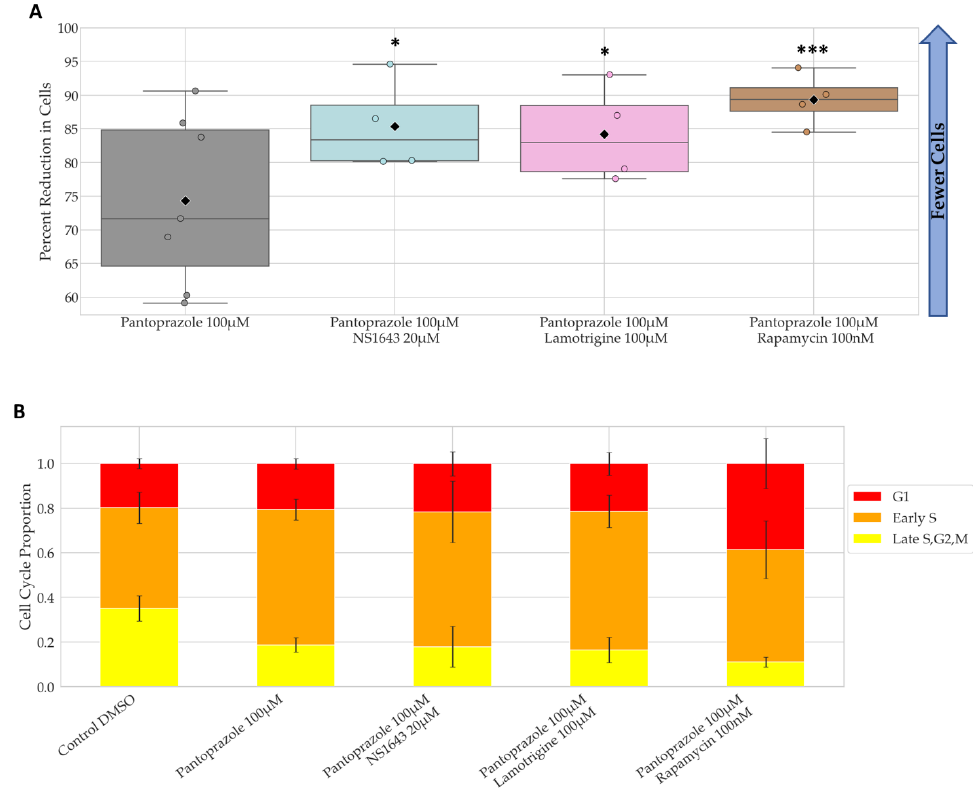
Cancers 2022 , 14 , x 11 of 38 Figure 2. Combinations of Pantoprazole with Bioelectric Compounds Significantly Decrease Proliferation Compared to Pantoprazole Alone and Show Changes in Cell Cycle Ratio. ( A ) Percent reduction in cells compared to control after 6 days of treatment. Treatments that were significantly more effective than pantoprazole alone are shown out of 32 treatments. Statistical analysis was conducted on the log2 of the fold change in cell number to control on day 6. ***: q < 0.001, *: q < 0.05 (one-way ANOVA with FDR post hoc analysis n > 3 biological replicates). ( B ) FUCCI cell cycle data at day 6. Increased red and orange fractions indicate cell cycle arrest at G1 or G1 to S transition.